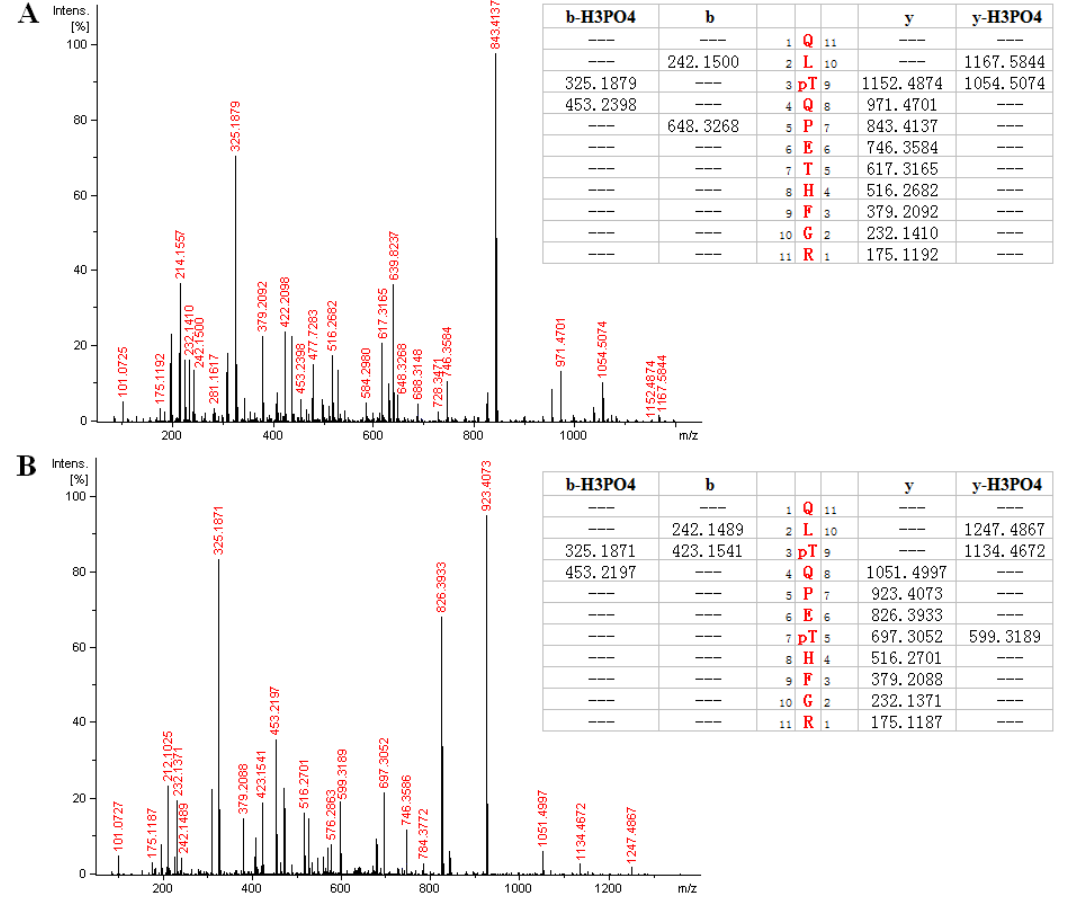
Figure 4. ( A ) MS/MS spectrum of a doubly-charged peak at m / z 697.321. The corresponding peptide is identified as QLpTQPETHFGR (289–299), in which Threonine 291 is phosphorylated; ( B ) MS/MS spectrum of a doubly-charged peak at m / z 737.304. The corresponding peptide is identified as QLpTQPEpTHFGR (289–299), in which both Threonine 291 and Threonine 295 are